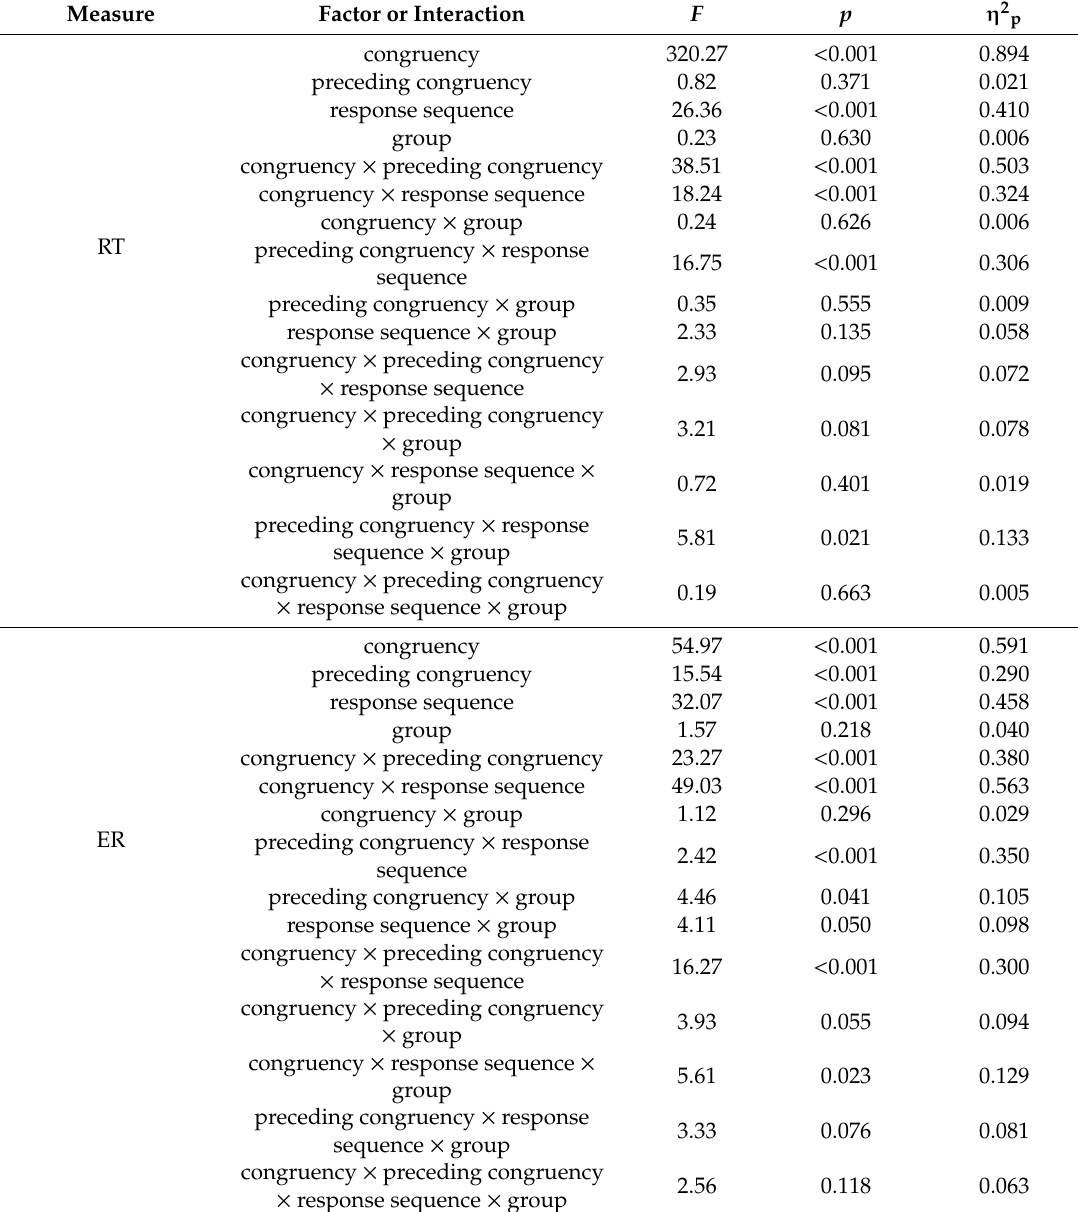
Table 4. Overview of ANOVA results for reaction times (RTs) and error rates (ERs).